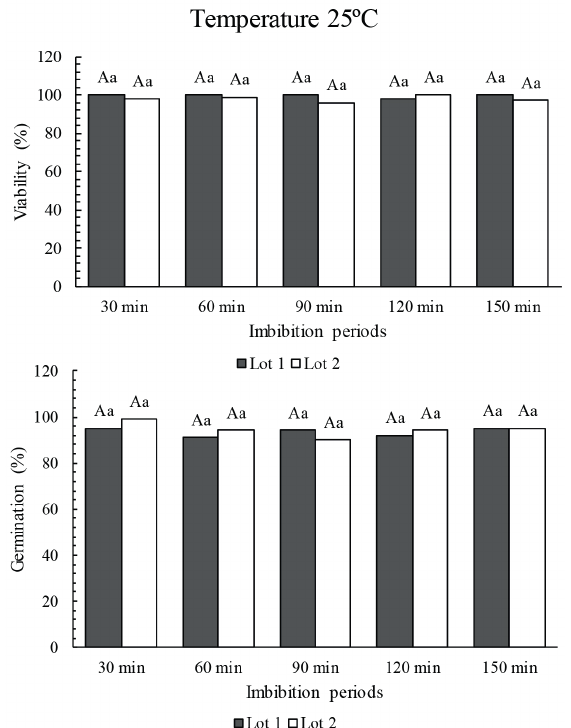
Figure 1 - Percentage of viability and germination by pH test of the individual exudate of two seed lots of Libidibia ferrea at 25ºC as a function of imbibition periods. *Means followed by the same lowercase letter in the line do not differ statistically from each other by the Tukey test at 5%